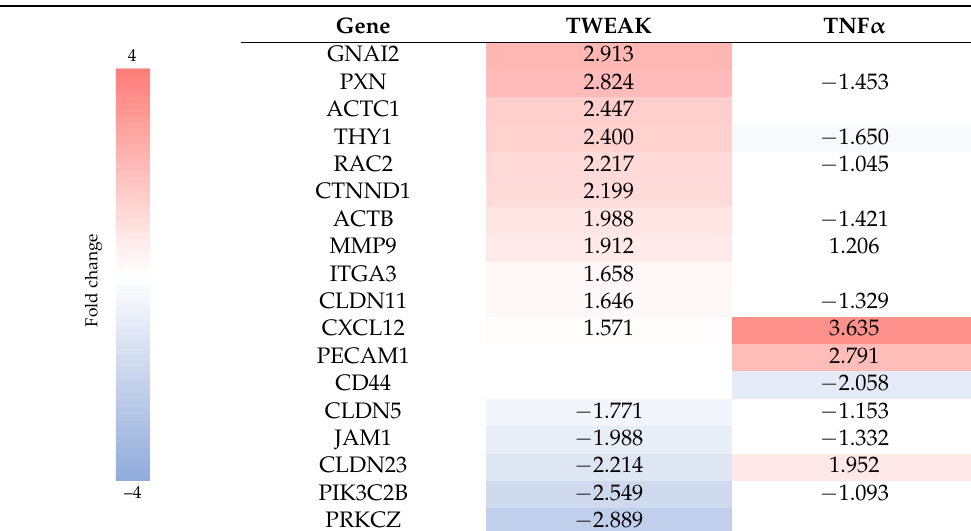
Table 2. Comparison of FCs of DEGs belonging to leukocyte extravasation signaling obtained via microarray and qPCR assays performed on hCMEC/D3 cells after 24 h incubation in TWEAK or TNF α . Upregulated genes (FC > 1.5) are in red and downregulated genes (FC < -1.5) are in blue.